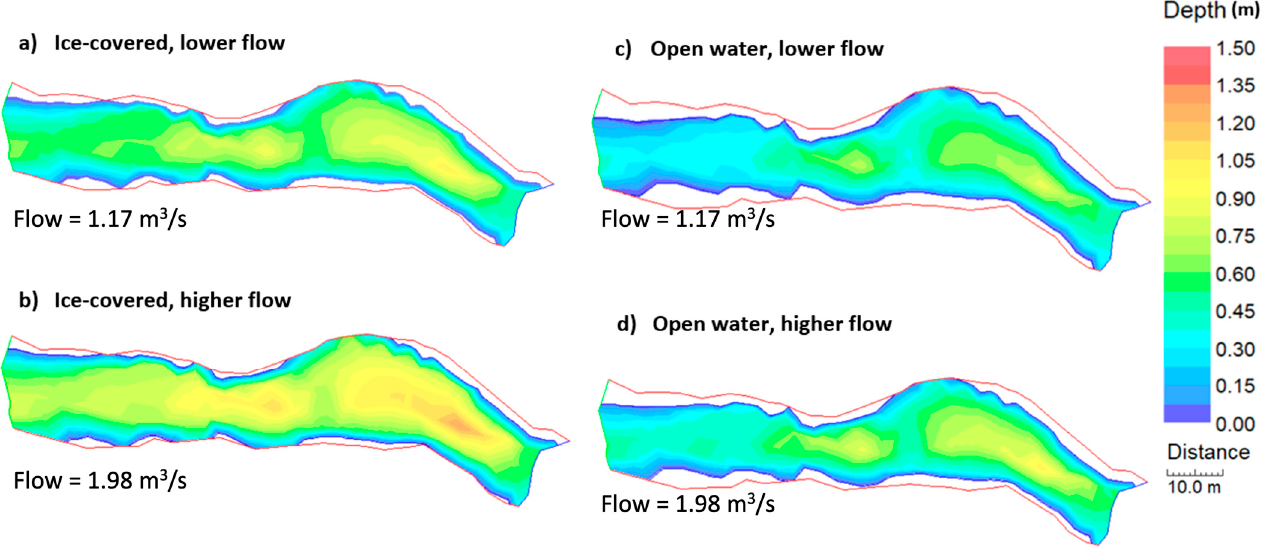
Figure 4. Modeled water depth under ( a ) lower flow, ice-covered conditions; ( b ) lower flow, open- water conditions; ( c ) higher flow, ice-covered conditions; and ( d ) higher flow, open-water conditions. Prepared in River2D.